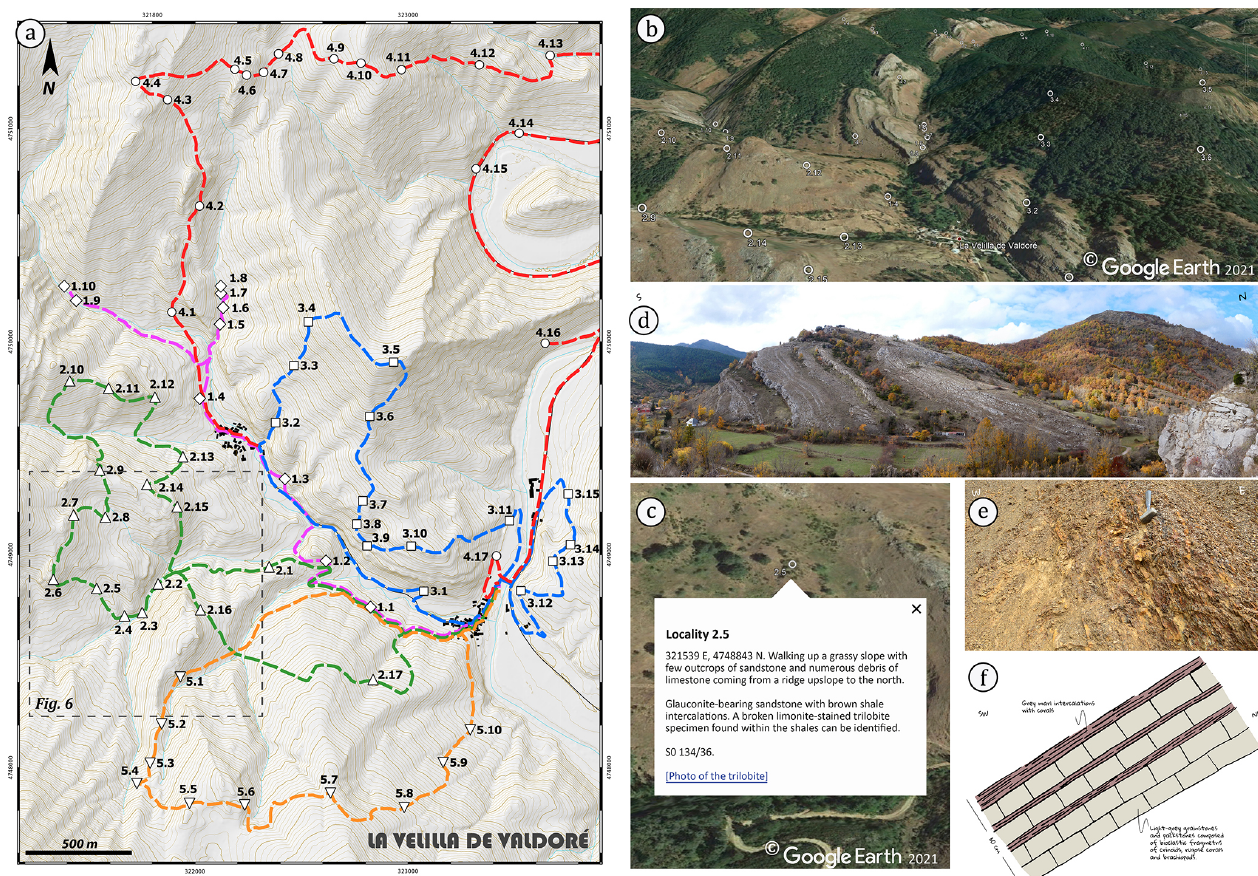
Figure 2. Outline of different elements of the Esla Mapping Project. (a) Daily itineraries of realistic walking distance with a number of stops along the way. The XY notation refers to the day ( X ) and the stop ( Y ). Map derived from digital elevation model provided by IGN (National Geographic Institute of Spain). See Fig. 1a for the location. (b) Tilted view of the northern part of the mapping area looking north with the stops shown as white symbols (© Google Earth 2021). Based on the information contained on each of the stops, students coloured the pins accordingly. (c) Example of data provided to the students at one of the stops. The photo of the trilobite is accessed by a link to an image stored in the GitHub repository, opened within Google Earth (© Google Earth 2021). (d) Panoramic view provided at stop 3.13 looking west: students were asked to inspect it and draw an annotated field sketch. (e) Outcrop photograph provided at stop 4.3 to familiarise the students with the provided rock description. (f) Outcrop sketch provided as data to the students at stop